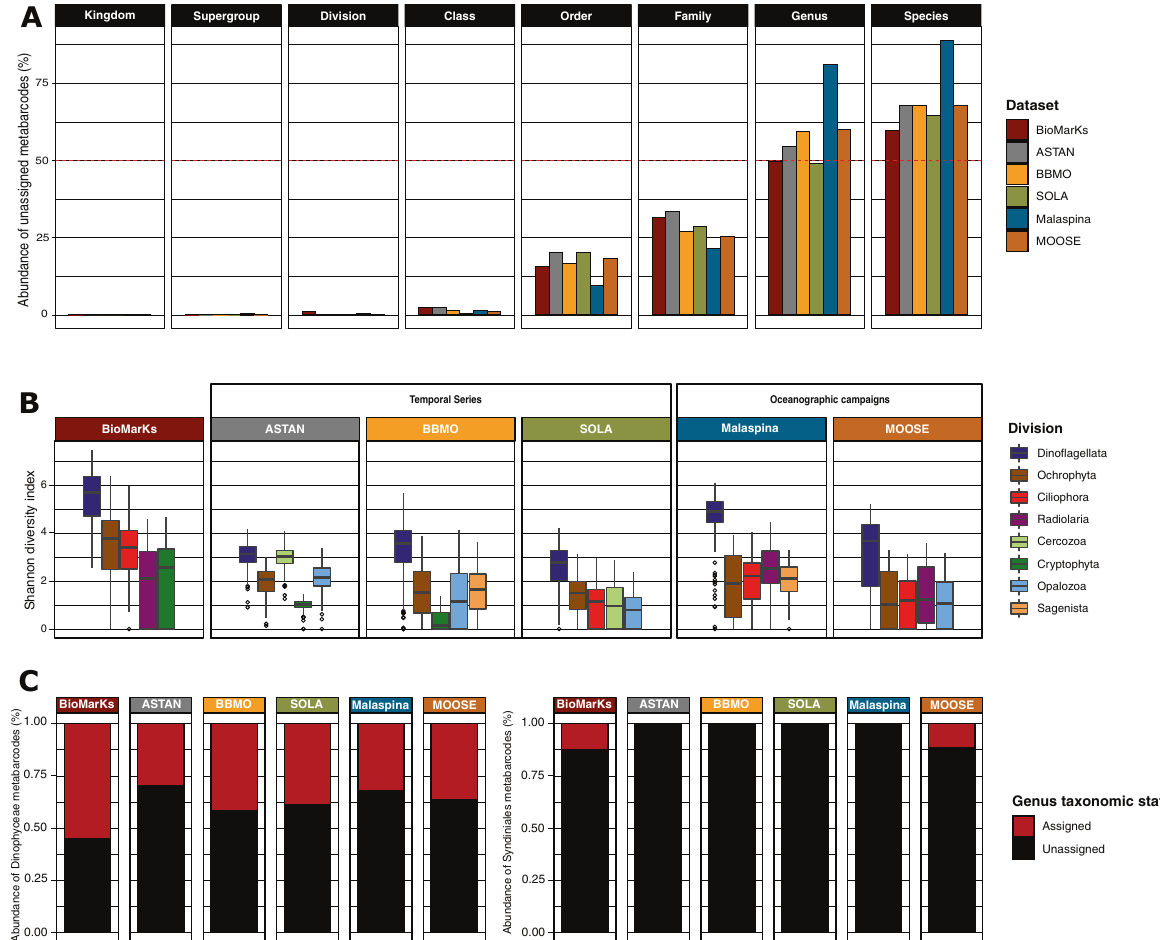
Fig. 1 Relative abundance and diversity of unassigned metabarcodes. A Relative abundance of unassigned metabarcodes at each taxonomic level from kingdom to species. Colors represent the 6 studied datasets. The horizontal red dashed line marks 50% of the dataset in terms of relative abundance. B Shannon Weiner diversity index calculated at genus level within major protist divisions in each dataset. Only metabarcodes unassigned at genus level are selected. Colors indicate the protist divisions that represent >50% of unassigned metabarcodes at genus level in each dataset (Supplementary Fig. S5). C Relative abundance of assigned and unassigned metabarcodes within the class Dinophyceae (left) and Syndiniales (right) found in each dataset. Colors indicate the taxonomic status (Assigned/Unassigned) of metabarcodes at genus are not exclusive) (Fig. 3A). Notably, a pattern of shared shared between the Bay of Biscay and the Mediterranean Sea and Syndiniales CCs was also found between bathypelagic samples between the Black Sea and the Mediterranean Sea (Fig. 2C). Dino- from the Mediterranean Sea and samples from the photic zone of Group-V included 13 CCs (0.3% of unassigned Syndiniales CCs the Tropical/Subtropical Ocean (29% CCs) (Fig. 3A). (Supplementary Fig. S7B)) and included CCs exclusively shared In order to test if these shared diversity patterns can be between the English Channel and the Tropical/Subtropical Ocean explained by similar physicochemical conditions, we explored (Fig. 2D). The Unknown Syndiniales order included 10 CCs (0.2% of the abundance variation of unassigned Syndiniales CCs in the unassigned Syndiniales CCs (Supplementary Fig. S7B)) and was mediterranean and tropical waters in an RDA using the found in 3 sea regions: Mediterranean Sea, Tropical/Subtropical physicochemical parameters as explanatory variables. The varia- Ocean (main pattern for this order, 9 CCs) and North Sea (1 CC tion of physicochemical parameters explained ~10% (11.2% in fi rst shared between the 3 mentioned sea regions) (Fig. 2D). 6 RDA dimensions) of the abundance variation of unassigned Since for all Syndiniales orders 50% of unassigned CCs were Syndiniales CCs (Fig. 3B). Based on this result, two communities of found to be exclusively common to mediterranean and tropical Syndiniales could be distinguished according to the fi rst two regions we further explored how this pattern was distributed dimensions of the RDA: a deep water (>200 m) community across the water column. Among the 2171 CCs exclusively shared associated with colder and more eutrophic conditions (Fig. 3B, between mediterranean and tropical waters, Syndiniales commu- left) and a photic (surface and DCM) community associated with nities were the most similar in the photic zone with 63% of CCs warmer and more oligotrophic conditions (Fig. 3B, right). In the common between DCM (Deep Chlorophyll Maximum) layers and RDA space associated with the photic zone, mediterranean and ~30% common between surface and DCM reciprocally (34% CCs tropical samples partly overlap and correspond to warmer and less common between Tropical/Subtropical Ocean DCM and Mediter- salty waters, hence providing an environmental basis for the ranean Sea surface; 32% CCs common between mediterranean observed Syndiniales pattern in these two marine environments DCM and Tropical/Subtropical Ocean, n.b. percentages are (Fig. 3A). indicative of major trends and not proportion as combinations